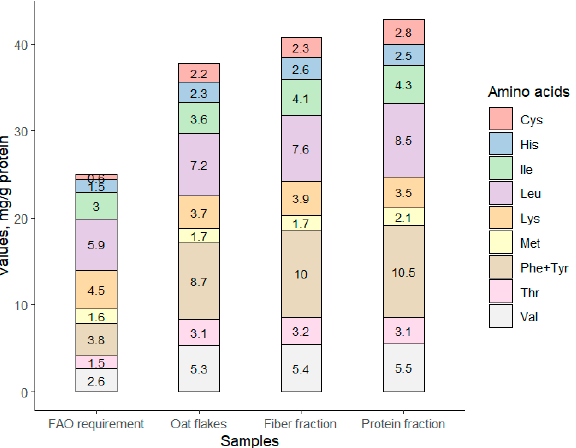
Figure 4. Amount of indispensable amino acids in initial oat flakes, averaged fiber and protein fractions, and FAO (2007) recommended values, mg/g protein.